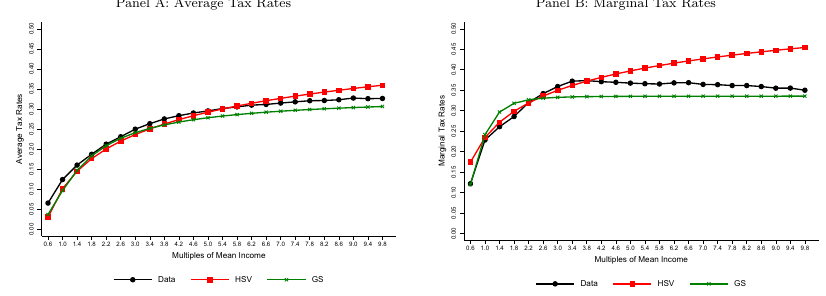
Fig. 5 Effective tax functions (individuals